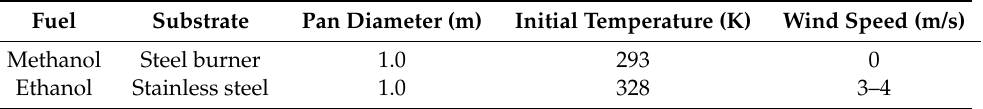
Table 1. The main boundary conditions implemented in this work, selected to mimic experimental data retrieved in the literature [36,37].